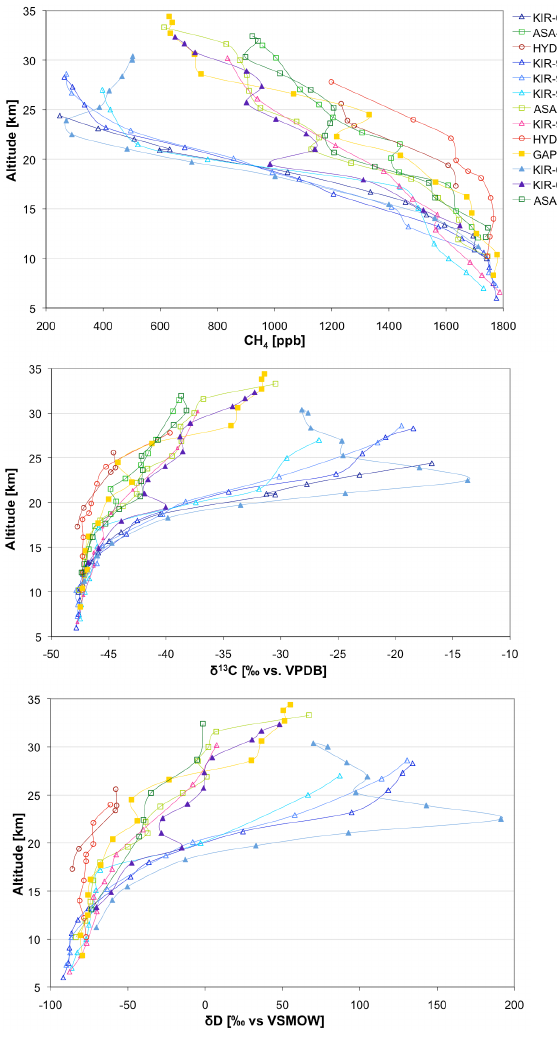
Fig. 1. Methane mixing ratio (a) , δ 13 C (b) and δ D (c) for all anal- ysed balloon samples. 1 : Arctic samples (blue: vortex, purple: non-vortex, (cid:3) : mid-latitudes (green, yellow), solid symbols: sam- pled in summer, (cid:13) : tropics (red).